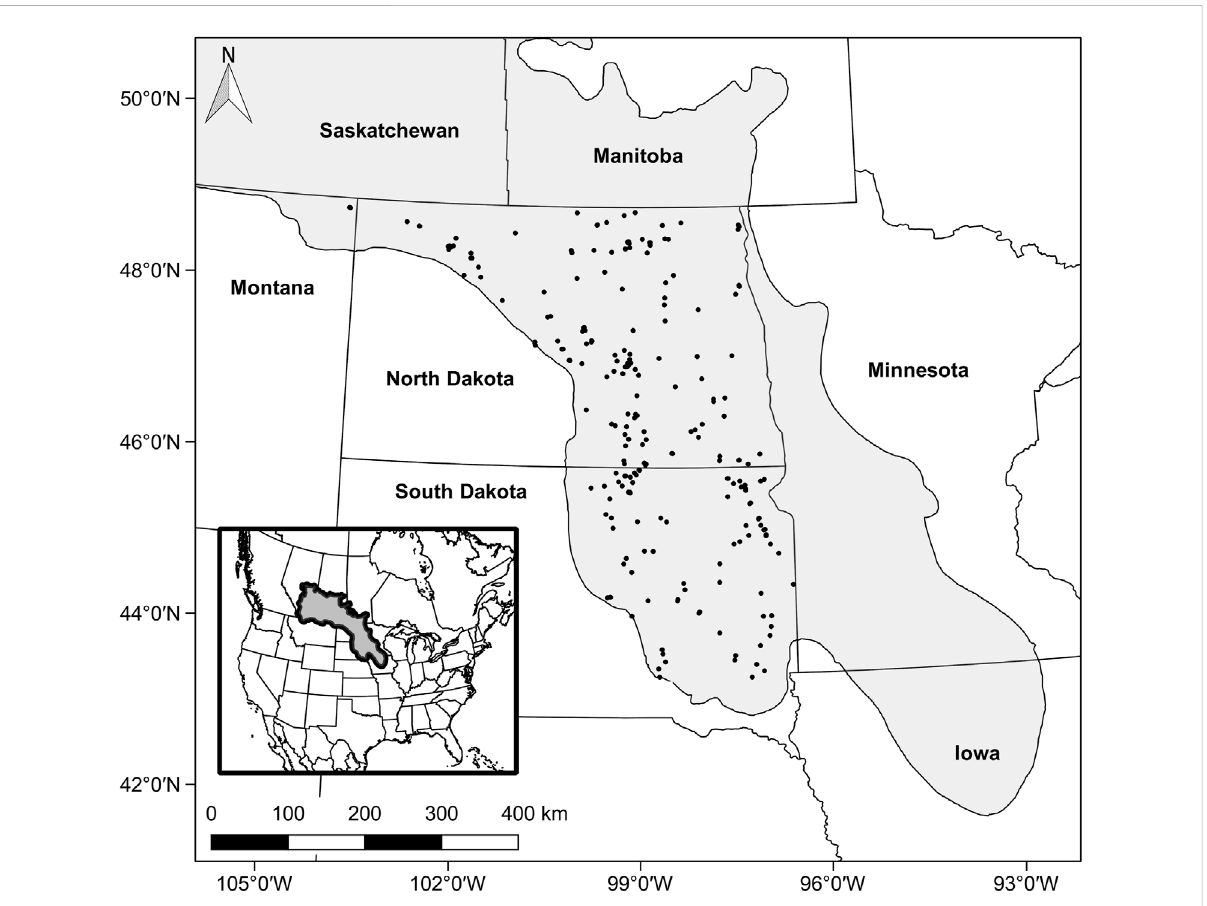
FIGURE 1 ThePrairiePotholeRegionofNorthAmerica(shadedarea).Dotsindicatethelocationofwetlandsselectedforthe2020 – 2021casestudyinthe United States portion of the